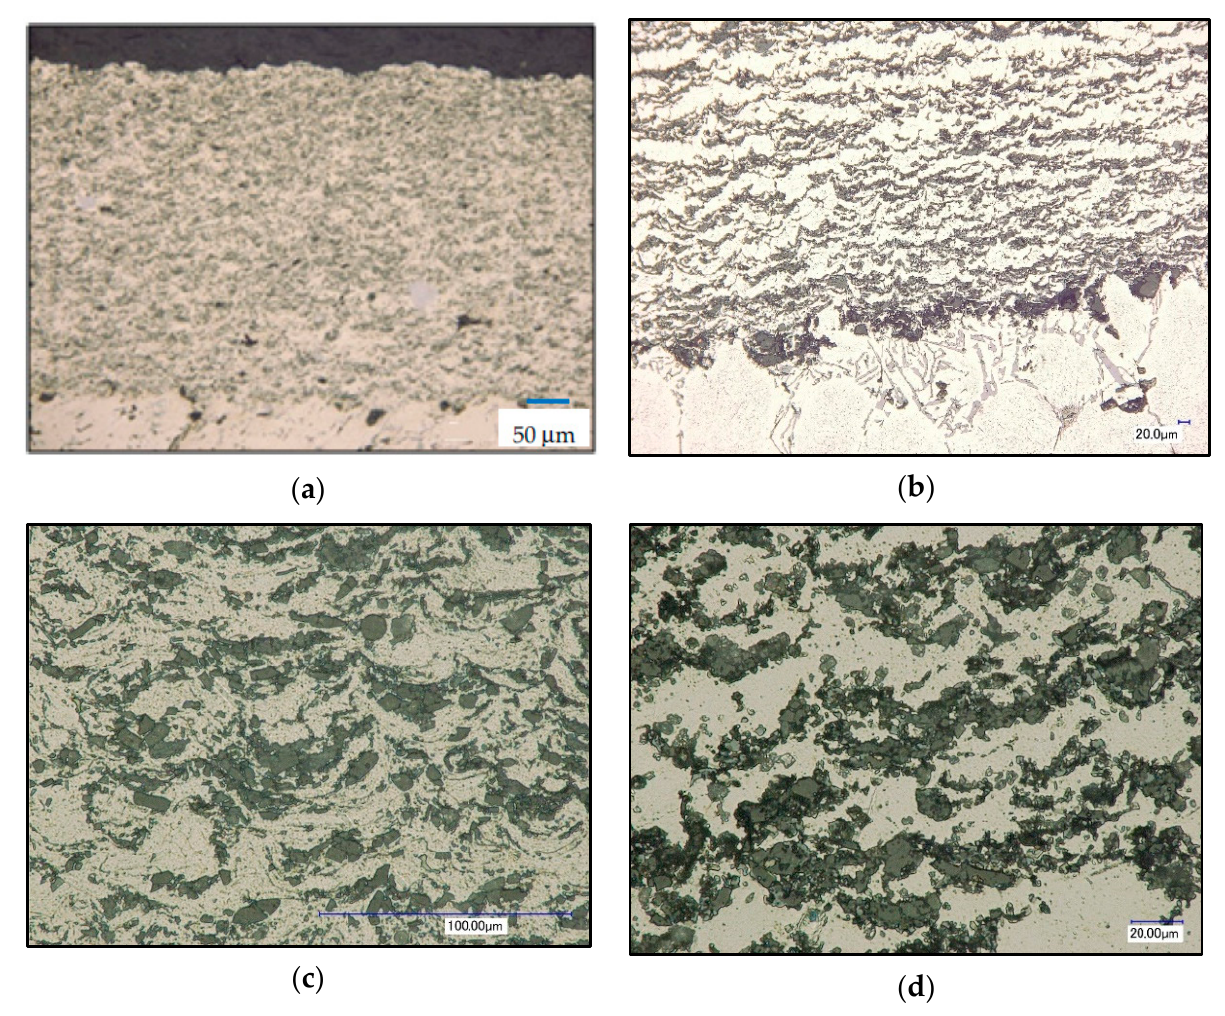
Figure 12. ( a , c ) OM micrographs of Al-75%ZrO 2 coating after cold spraying (magnification ×250); ( b , d ) following sintering at 600 °C (magnification ×500).